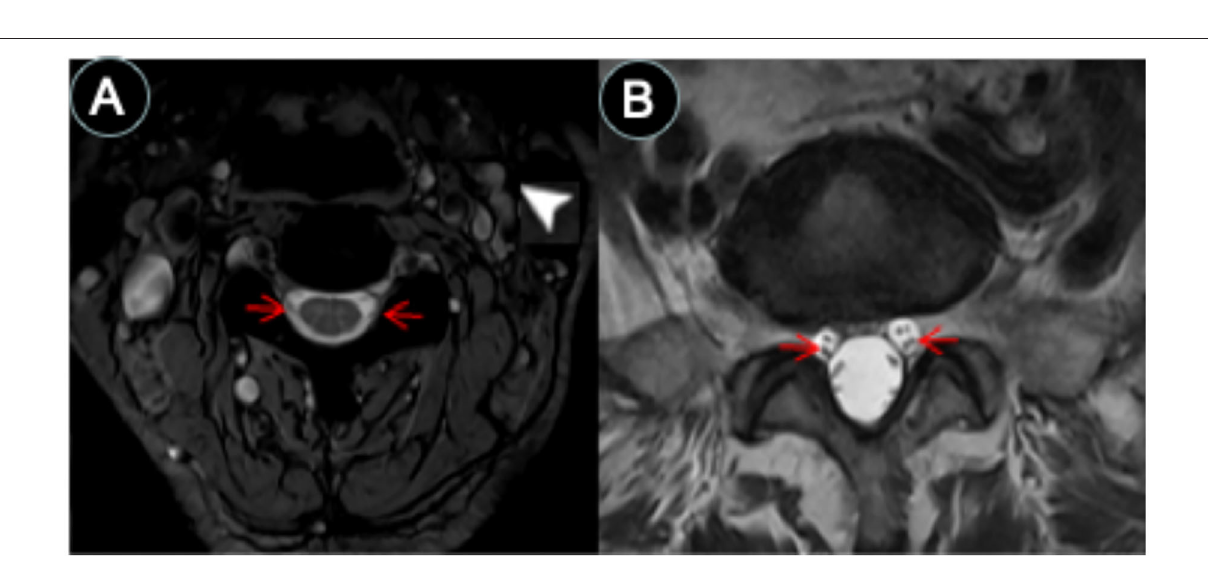
FIGURE 3 | CSF-filled peri-neural spaces surrounding spinal nerves. (A) Cervical spinal nerves (brachial plexus). Cervical nerves four are pointed with red arrows (hypointense signal), and the space surrounding the nerves is the CSF-filled peri-neural space (hyperintense signal). Multiple lymph nodes are detected from MRI (white arrowhead). (B) Lumbar spinal nerves (red arrows, hypointense signal) surrounded with CSF-filled peri-neural space (hyperintense signal). Images were generated from the third and the fourth experiments as described in the method section.